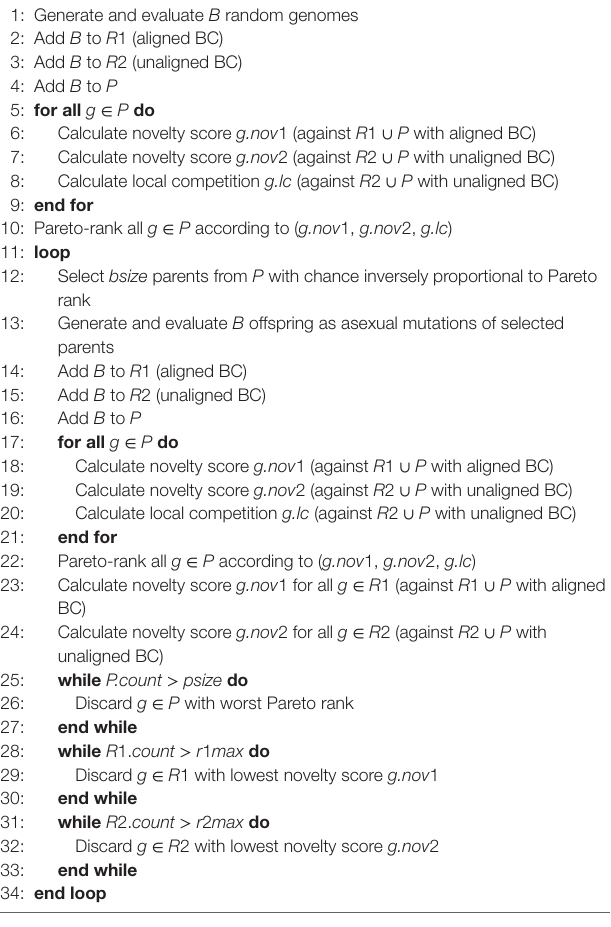
algorithm 3 | Multi-Bc novelty search with local competition (ns-nslc)